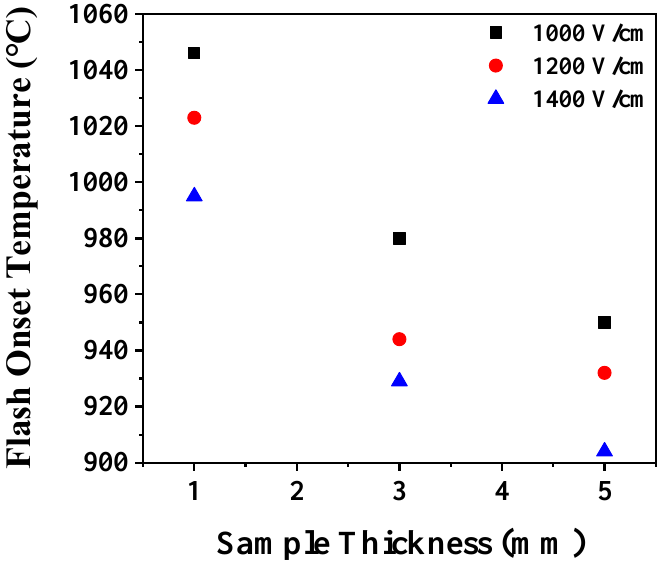
Figure 4. Change of flash onset temperature with a sample thickness.